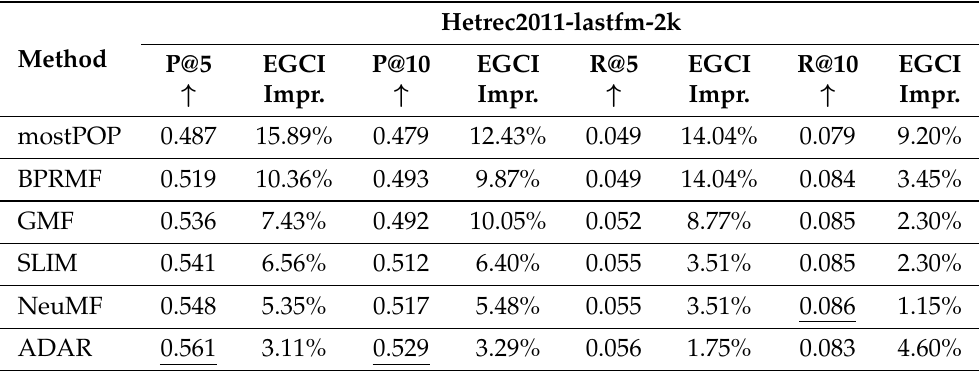
Table 6. Comparison of precision and recall on the Hetrec2011-lastfm-2k dataset.